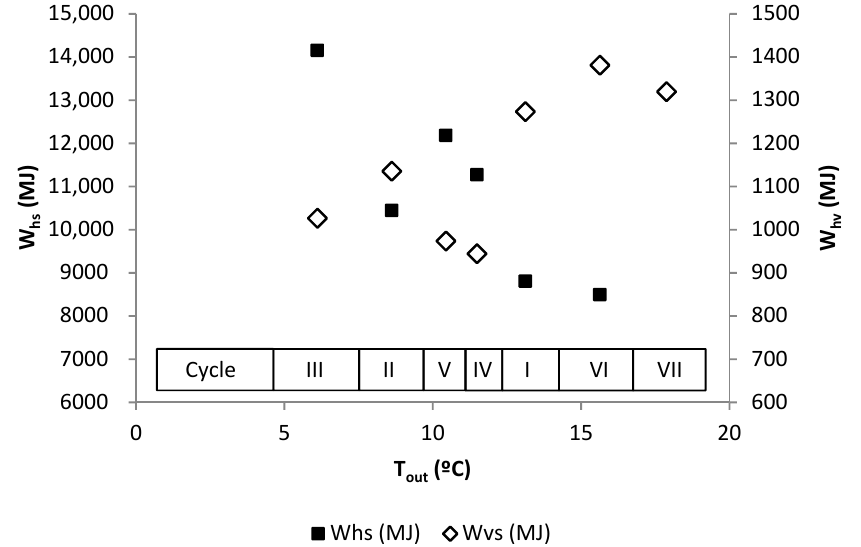
Figure 6. Energy requirements for heating (W hs ) and ventilation (W vs ) systems according to outdoor temperature (T out ) for each cycle.